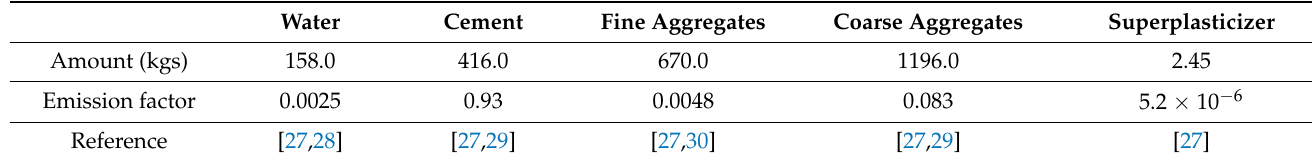
Table 2. Mix design details of 1 m 3 of concrete.